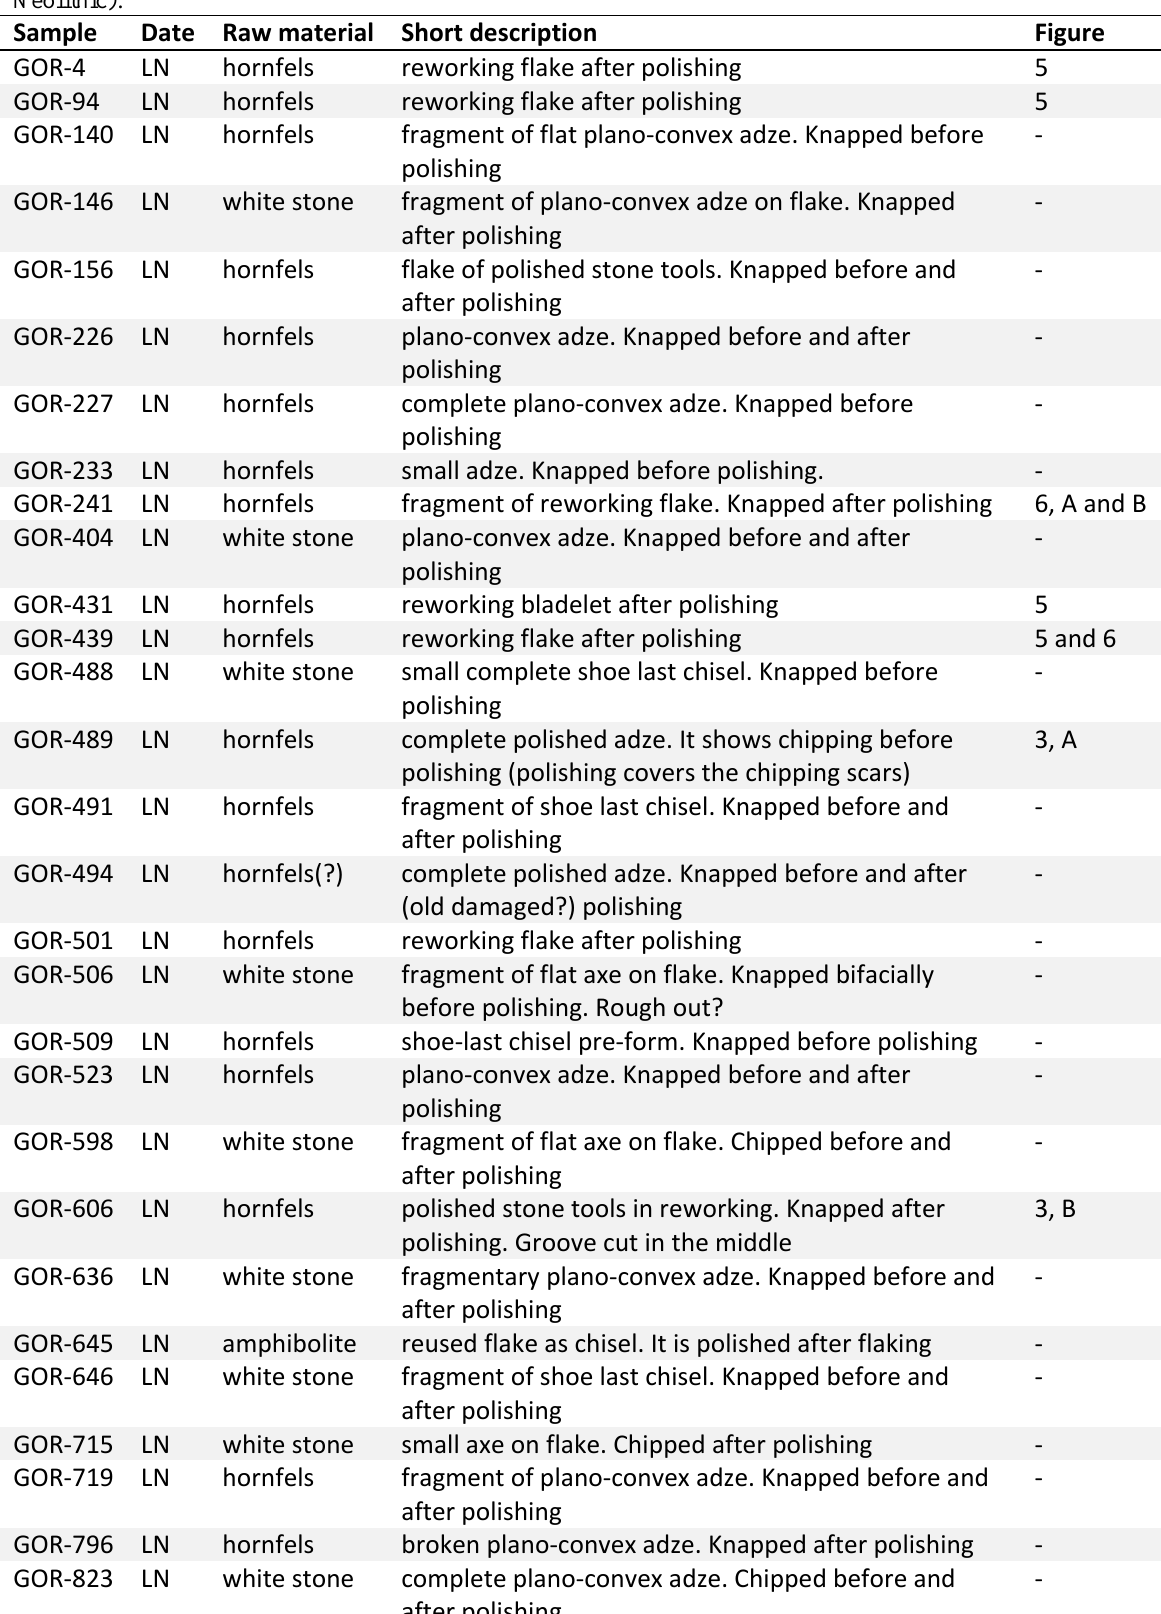
Table 1. List of unpublished polished stone artefacts showing scars of flaking technology from Hódmezővásárhely -Gorzsa (GOR-), Tápé- Lebő (TL -) and Pitvaros (PIV-) (EN for early Neolithic; LN for late